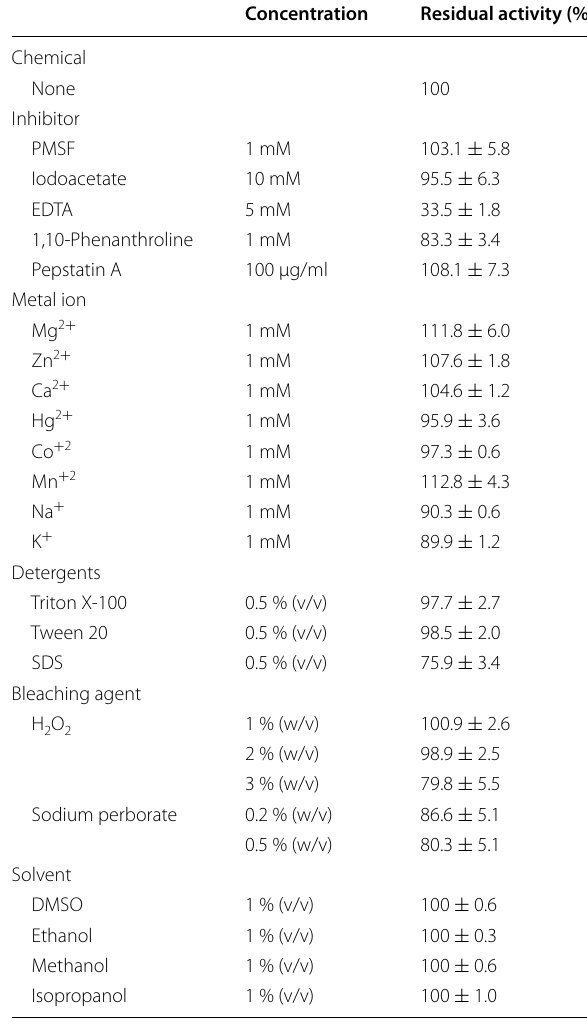
Table 2 Effect of chemical agents on keratinase activity. Values are the mean of three replicates standard deviation. 100% of ± activity corresponds to those displayed by the enzyme without the presence of any